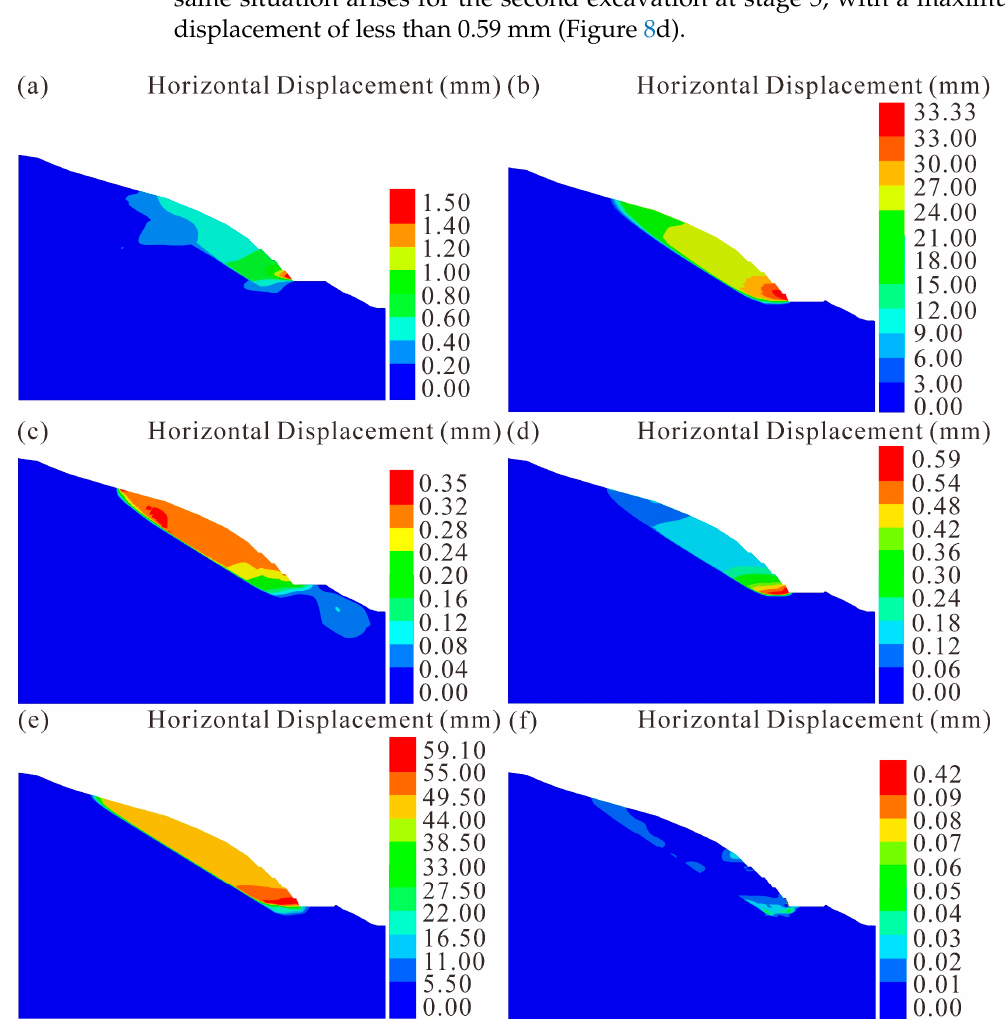
Figure 8. Numerical simulation of the Anling landslide. ( a ) Deformation of the landslide before stage 5. ( b ) Deformation of the landslide after the first excavation at stage 5. ( c ) Deformation of the landslide after backfilling and building prestressed anchor at stage 5. ( d ) Deformation of the land- slide after the second excavation at stage 5. ( e ) Deformation of the landslide during rainfall at stage 6. ( f ) Deformation of the landslide after building extra prestressed anchor at stage 6.